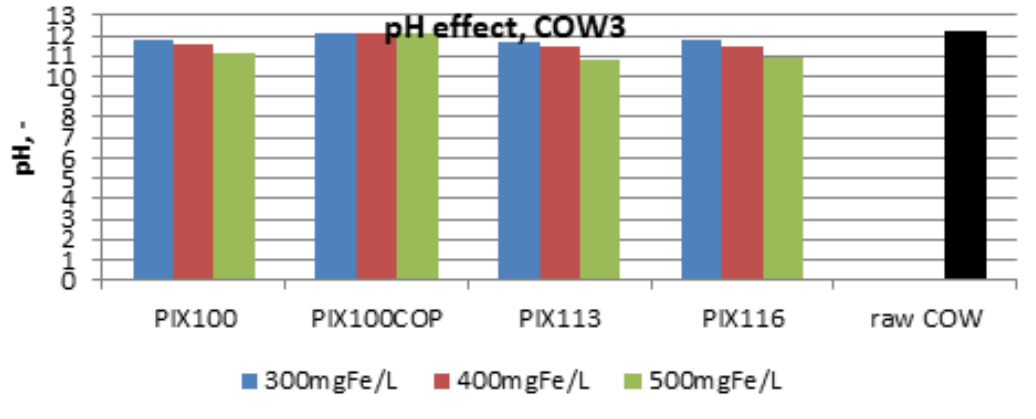
Figure 18: Effect of coagulant type and dose on pH of